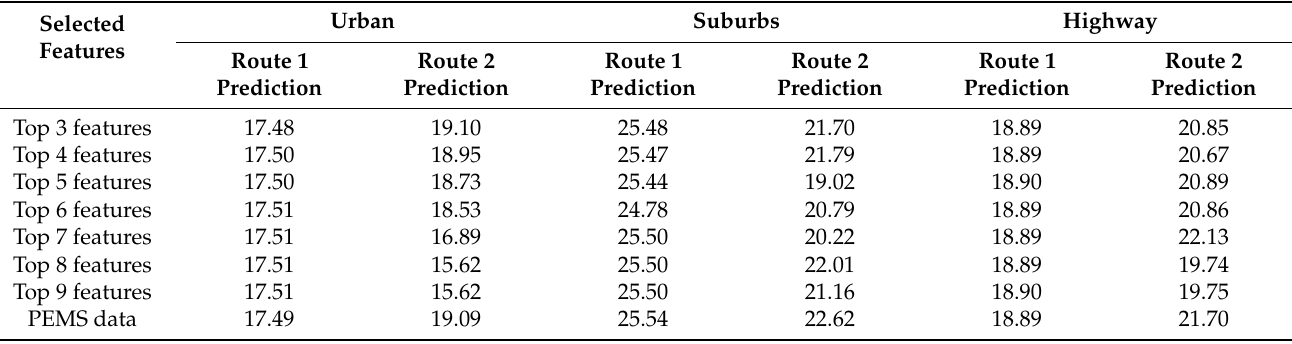
Figure 16. Second route CO 2 emission factor predictions by using route 1 using CO 2 urban model ( a ) Urban; ( b ) Suburbs; ( c ) Highway. Table 16. Fuel consumption km/L statistics results of route 1 and route 2.